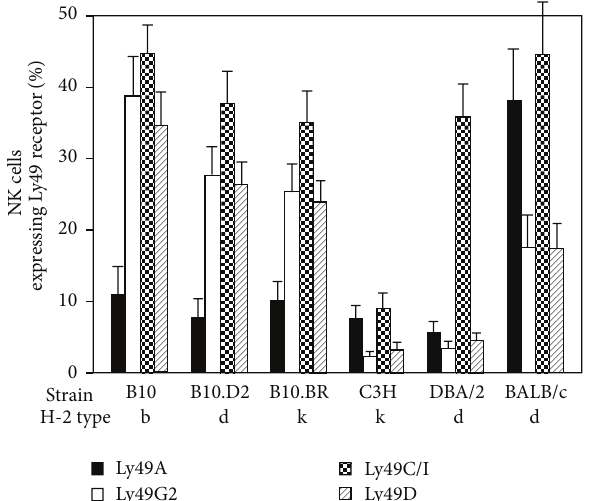
Figure 1: Distribution of Ly49 receptors in NK cells in different strains of mice. Freshly isolated splenocytes from B10 ( 𝑛 = 6 ), B10.D2 ( 𝑛 = 8 ), B10.BR ( 𝑛 = 7 ), C3H ( 𝑛 = 5 ), DBA/2 ( 𝑛 = 8 ), and BALB/c ( 𝑛 = 3 ) were evaluated by flow cytometer. We compared expression of Ly49 receptors on NK cells in different strains of mice. Ly49 receptors included Ly49A (its ligands are H- 2 d and H- 2 k ), Ly49G2 (H- 2 d ), Ly49C/I (H- 2 b ), and Ly49D (H- 2 k ). Data are expressed as the means ±